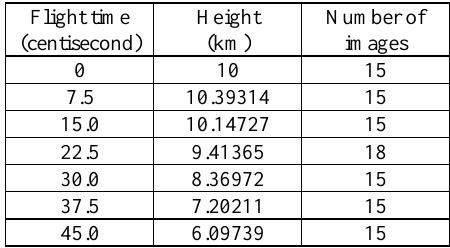
Table 2. Number of images for Database